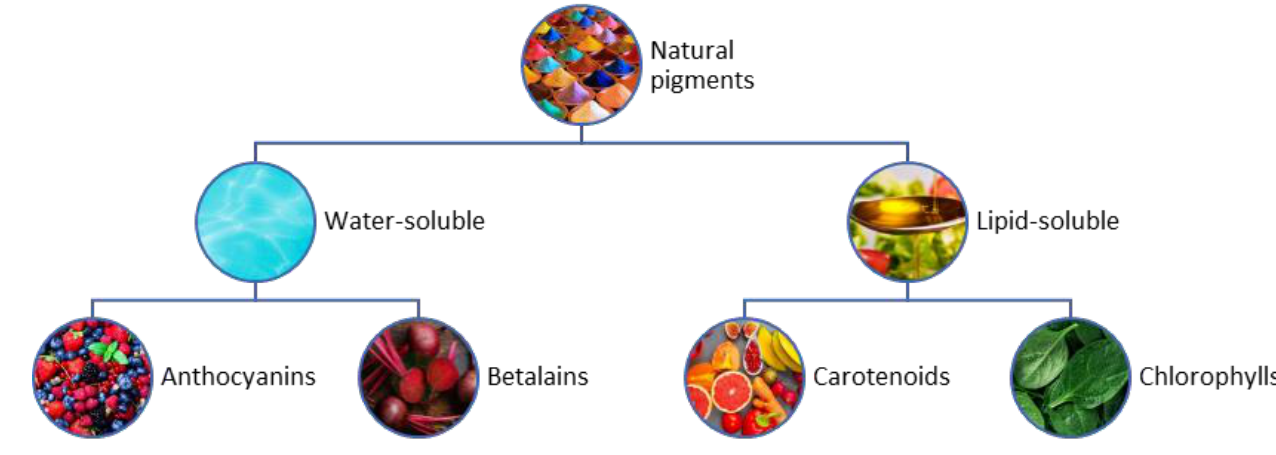
Figure 1. Classification of natural pigments (adapted from [83]). Anthocyanins (cyanidin, malvidin, delphinidin, peonidin, petunidin, and pelargoni- din) are water-soluble pigments, and part of the phenolic family, contributing to various colors (red, orange, blue, and purple) in flowers, fruits, and vegetables [77,78]. Due to their antimicrobial and antioxidant properties, and the ability to change in color with the change in pH, they are considered as suitable for active packaging. Roselle anthocyanins have been reported as suitable raw materials in combination with biodegradable poly- mers for monitoring the freshness of fish and meat products [84].